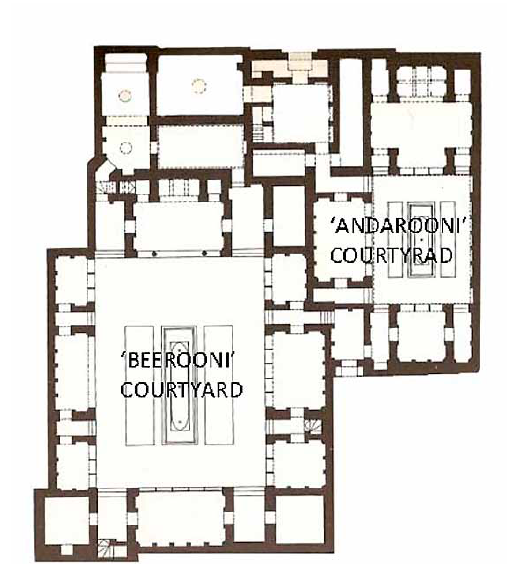
fig. 6. a plan of a TPH complex with two different ‘andarooni’ and ‘Beerooni’ courtyards in Gazorgah neighborhood in Yazd (Ghezelbash, abouzia 1985: